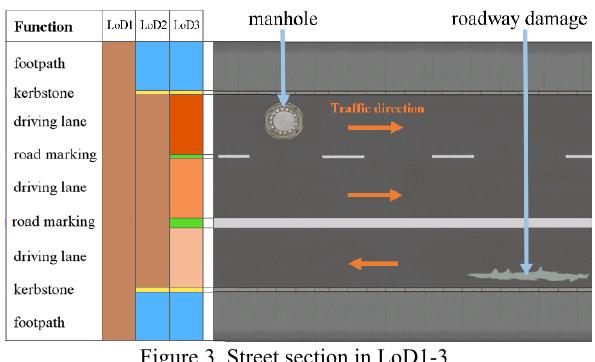
Figure 3. Street section in LoD1-3